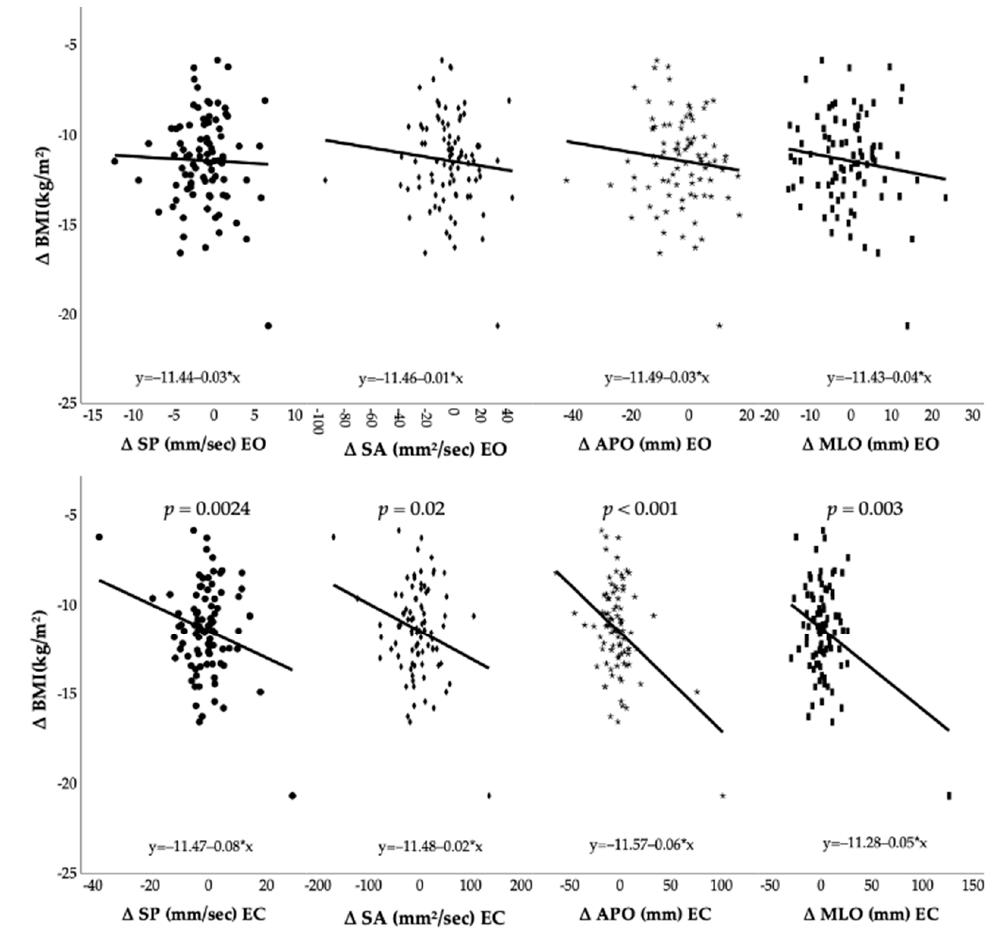
Figure 3. Post-surgery BMI loss and postural control changes. Abbreviations: ∆ : difference between post- and pre-surgery outcome; BMI: Body Mass Index; SP: sway path; SA: sway area; APO: antero- posterior oscillation; MLO: medio-lateral oscillation; EO: eyes opened; EC: eyes closed